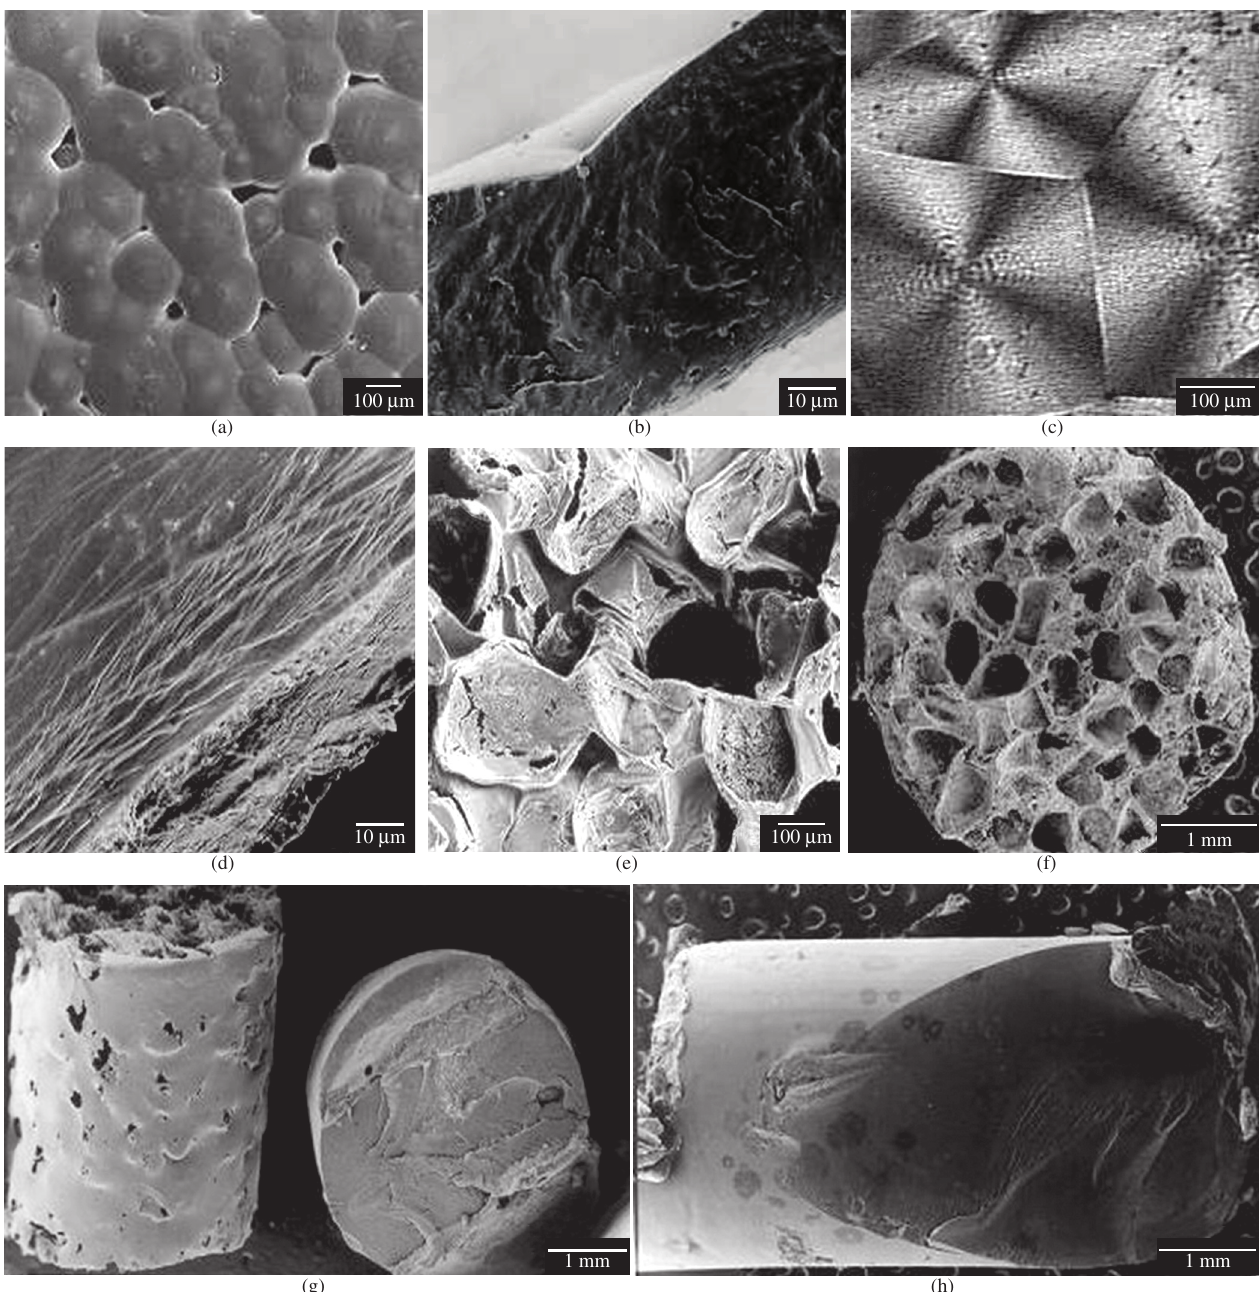
Figure 2. Scanning electron micrographs of PCL and PLGA50 scaffolds. a) and b) dense PCL membranes; c) Optic microscopy of PCL membranes; d) PLGA50 dense membranes; e) PCL porous membrane; f) PLGA50 porous rods; g) PCL porous (left) and dense (right) rods and h) PLGA50 dense